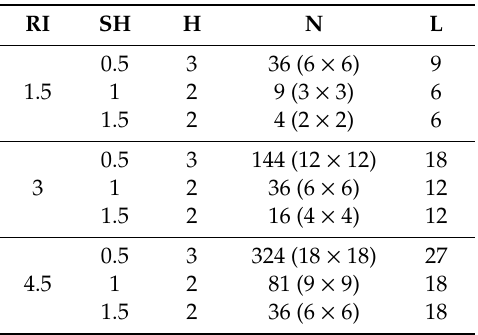
Table 1. The rooms and luminaire layouts parameters for the study.